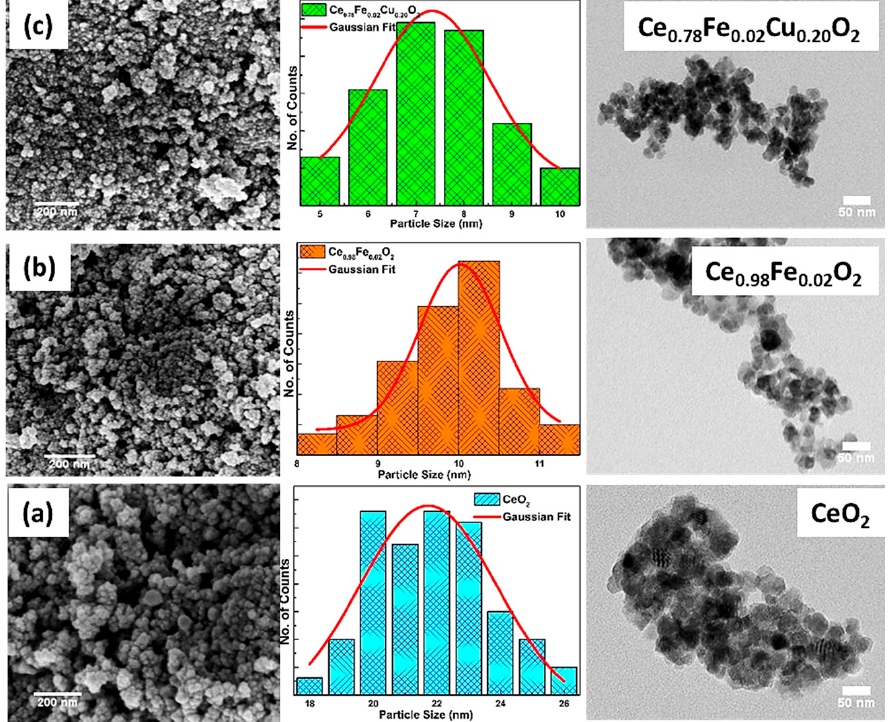
Figure 2. FE-SEM micrograph of ( a ) pure CeO 2 , ( b ) Ce 0.98 Fe 0.02 O 2 , and ( c ) Ce 0.78 Fe 0.02 Cu 0.20 O 2 nanoparticles, along with the corresponding TEM images. Table 1. The values of various parameters obtained, such as crystallite size (D), FWHM (d), lattice strain through XRD, and bandgap energy (Eg) from UV-vis analysis of pure CeO 2 , doped CeO 2 , and co-doped CeO 2 .